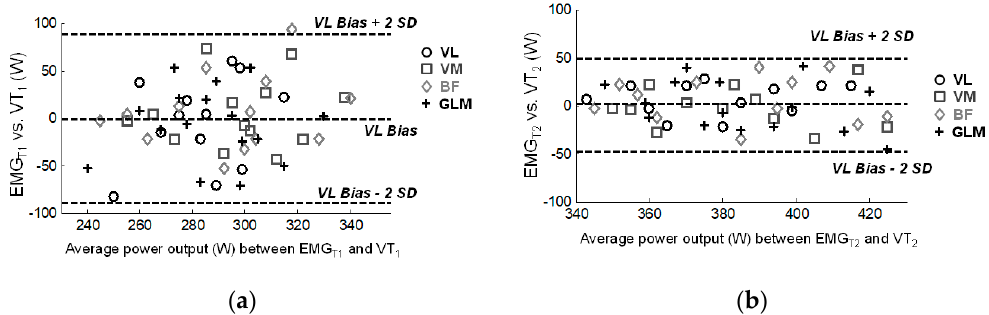
Figure 3. Graphic analysis of power output (W) data corresponding to ( a ) the first electromyographic threshold (EMG T1 ) and ventilatory threshold (VT 1 ), and ( b ) the second electromyographic threshold (EMG T2 ) and ventilatory threshold (VT 2 ), for the vastus lateralis (VL), vastus medialis (VM), biceps femoris (BF), and gluteus maximus (GLM).